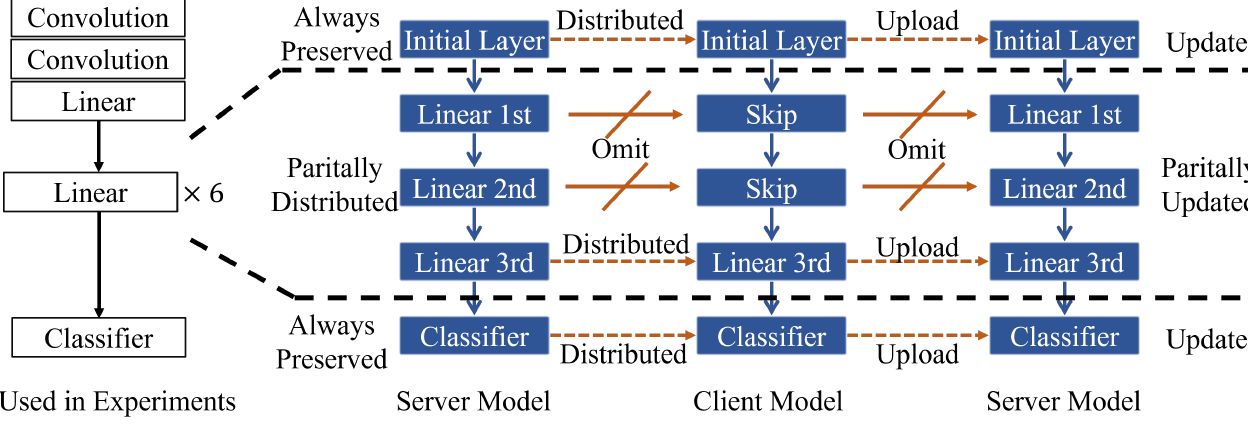
Figure 2. This figure shows the configuration of the server model used in the experiment and the process of generating an arbitrary derivative model to be distributed to the